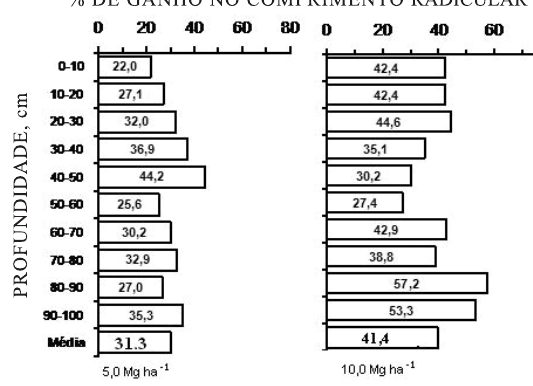
Figura 2. Percentagem de ganho no comprimento radicular (média de 13 genótipos) em cada camada amostrada nos tratamentos com 5,0 e 10,0 Mg ha -1 de palha, comparado ao tratamento sem palha. Os números inseridos nas barras horizontais representam a percentagem do ganho relativo. Média dos dois anos agrícolas (2001/02 e